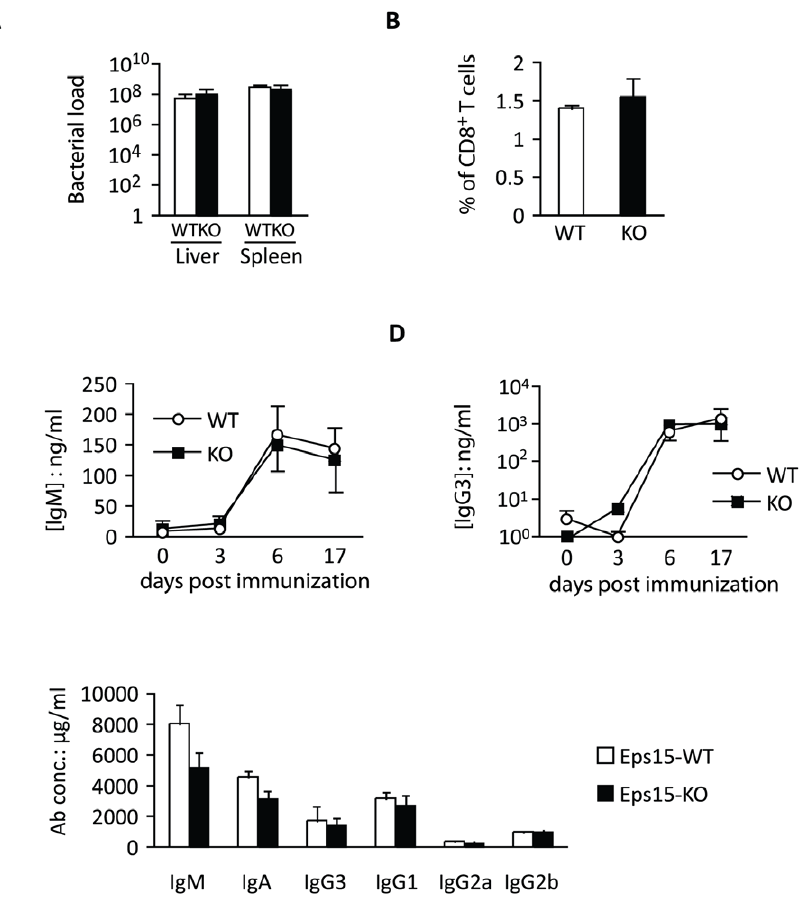
Figure 10. Normal immune-reactivity in Eps15-KO mice. A. Bar graph depicting the bacterial load of Listeria monocytogenes in the liver and spleen of Eps15-WT (WT, white bar) and Eps15-KO (KO, black bar) 3 month old mice (n=6), three days post-infection. B. Bar graph depicting the percentage of Listeria responsive CD8 + splenic T cells in 3 month old Eps15-WT (WT, white bar, n=2) and Eps15-KO (KO, black bar, n=3) mice seven days post-infection. C. – D. Line graph depicting the concentration of IgM ( C. ) and IgG3 ( D. ) in the serum of 2 month old Eps15-WT (WT, white circle, n=5) and Eps15-KO (KO, black square, n=6) mice before immunization and 3, 6 and 17 days post-immunization with 5 m g NP-Ficoll. E. Bar graph depicting the concentration of antibodies in the blood of 24-month-old Eps15-WT (WT, white bar, n=8) and Eps15-KO (KO, black bar, n=11) mice.